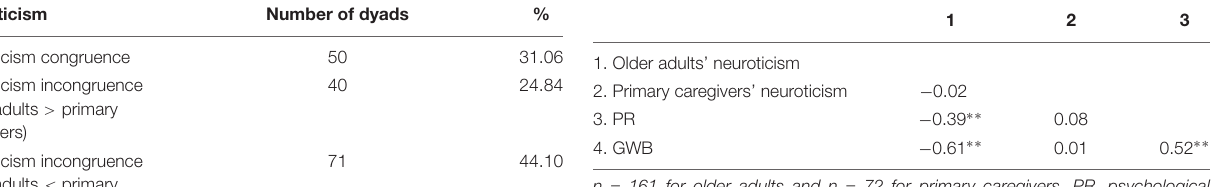
TABLE 2 | Descriptive statistics on congruent/incongruent dyads between older adults and primary caregivers ( n = 161). Neuroticism Number of dyads